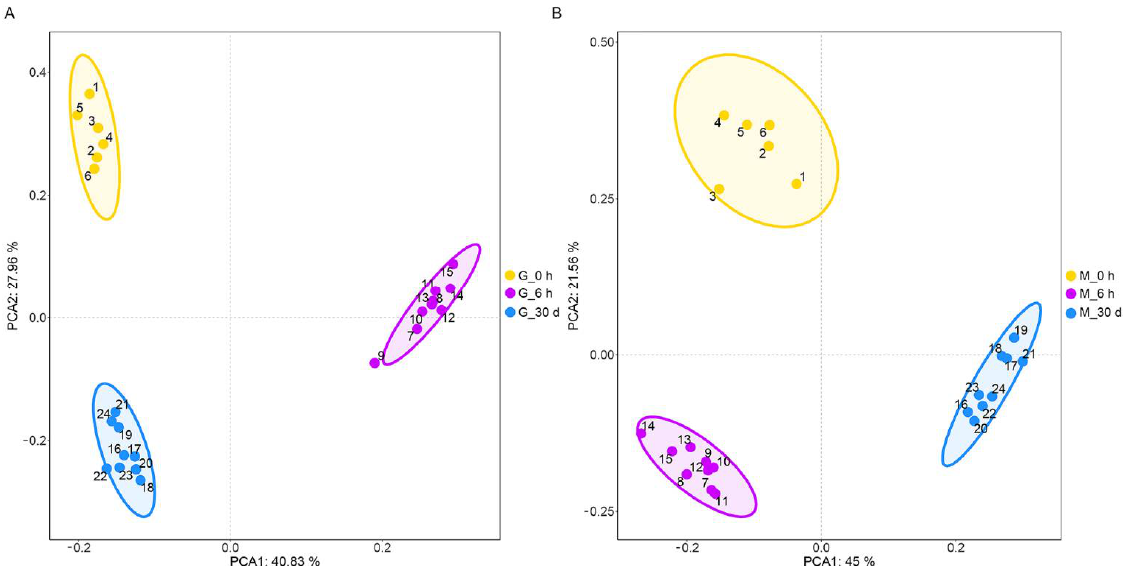
Figure 1. Principal component analysis (PCA) in gill ( A ) and mantle ( B ) of C. farreri under heat stress for 6 h and 30 d. Yellow dots: control (heat stress for 0 h); purple dots: heat stress for 6 h; blue dots: heat stress for 30 d.